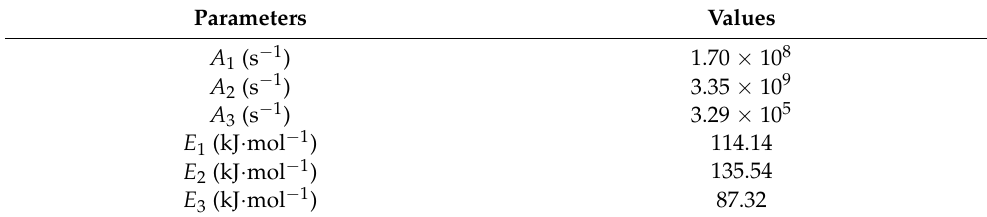
Table 2. Kinetic data obtained by the model.